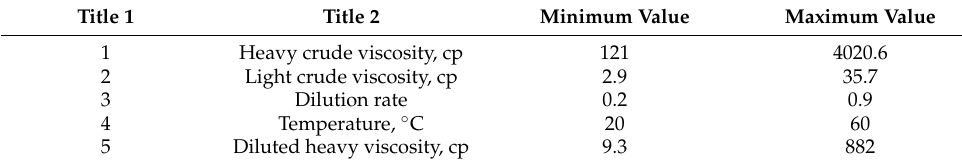
Table 1. Characteristics of